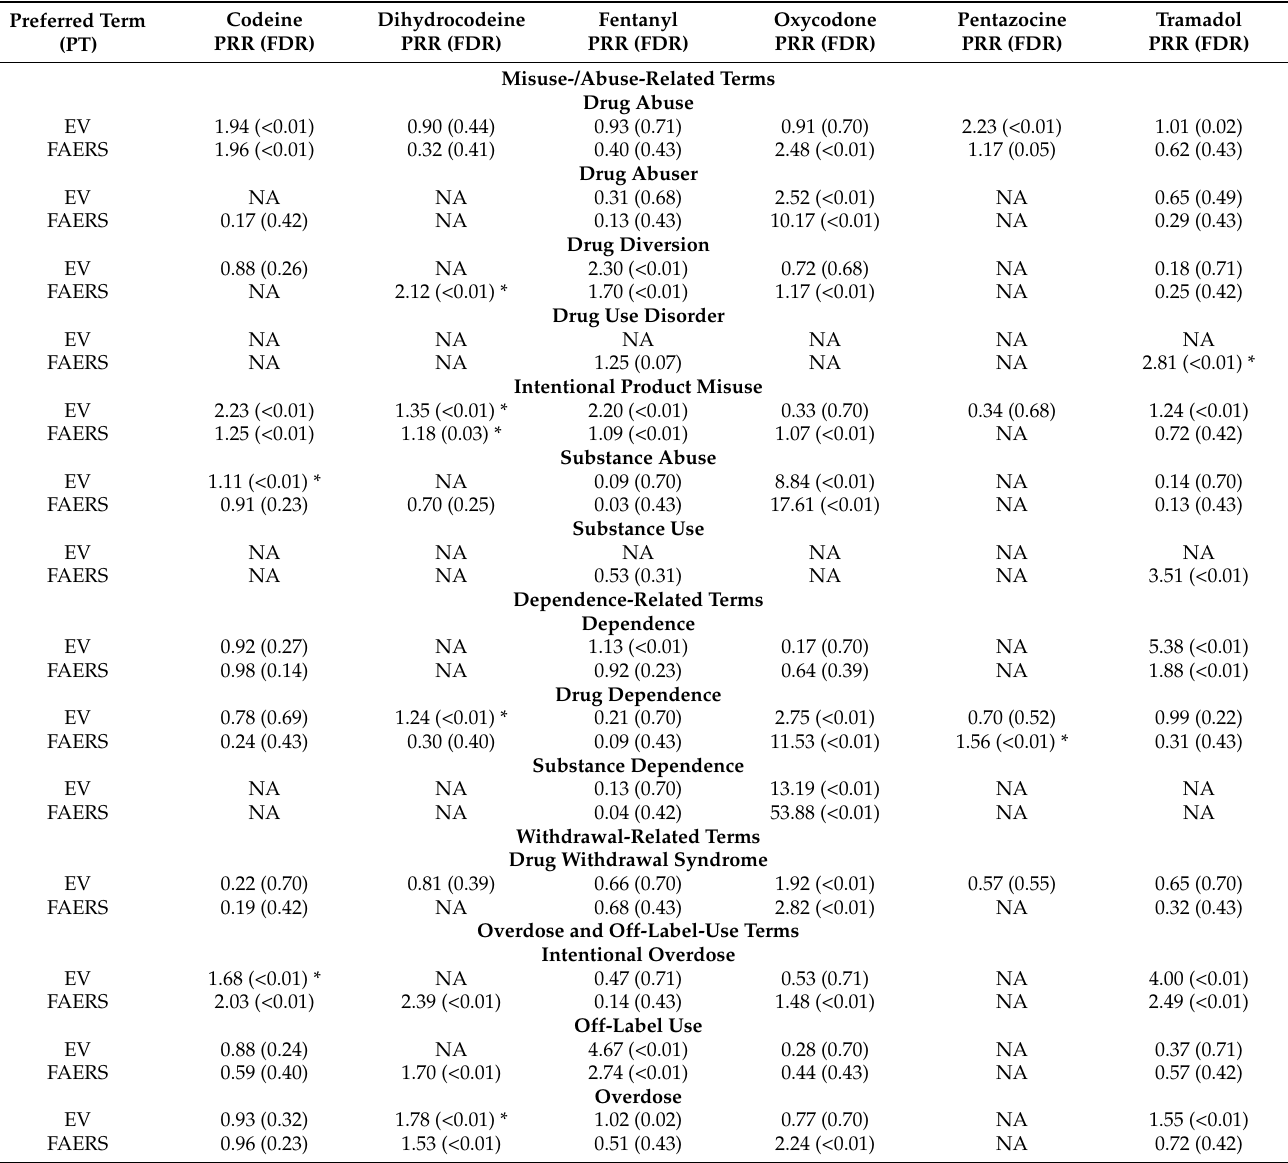
Table 2. Proportional reporting ratio signal scores regarding abuse/dependence and withdrawal issues for selected opioid drugs (European Medicines Agency EudraVigilance and the Food and Drug Administration (FDA) Adverse Event Reporting System